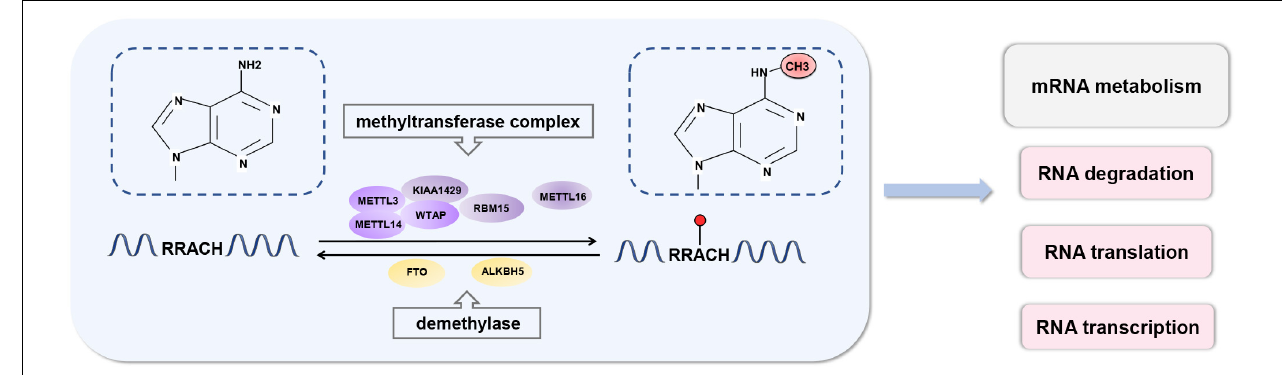
FIGURE 1 | Dynamic process of RNA N6-methyladenosine methylation. RNA m6A modification is a dynamic and reversible process. m6A can be installed by the methyltransferase complex and removed by demethylases. m6A modifications are enriched in the 3 (cid:48) -untranslated regions (UTRs) near the stop codons of mRNA and within internal long exons, mainly with a consensus sequence of RRACH. m6A participates in almost all processes in mRNA metabolism, including RNA transcription, translation, and